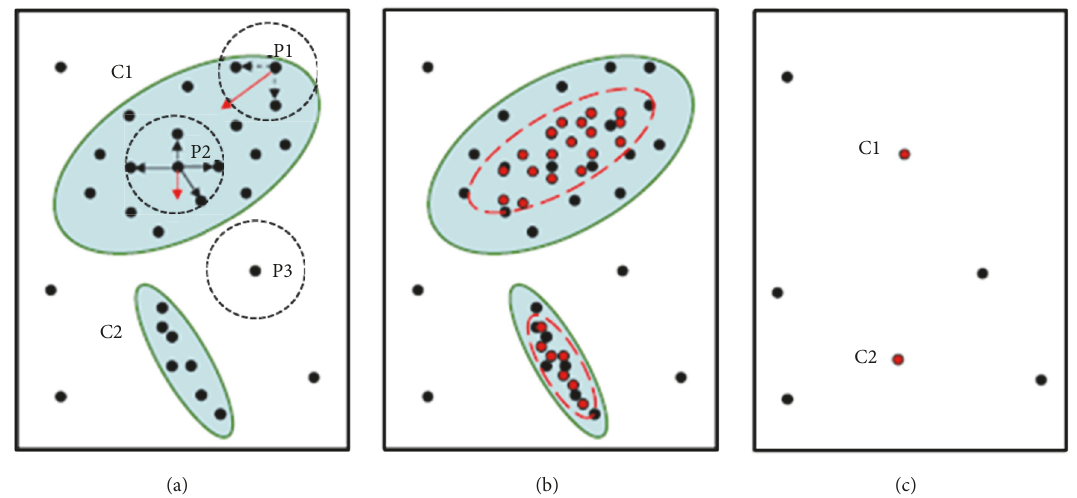
Figure 5: Sketch of synchronous clustering (SynC) algorithm process [28].